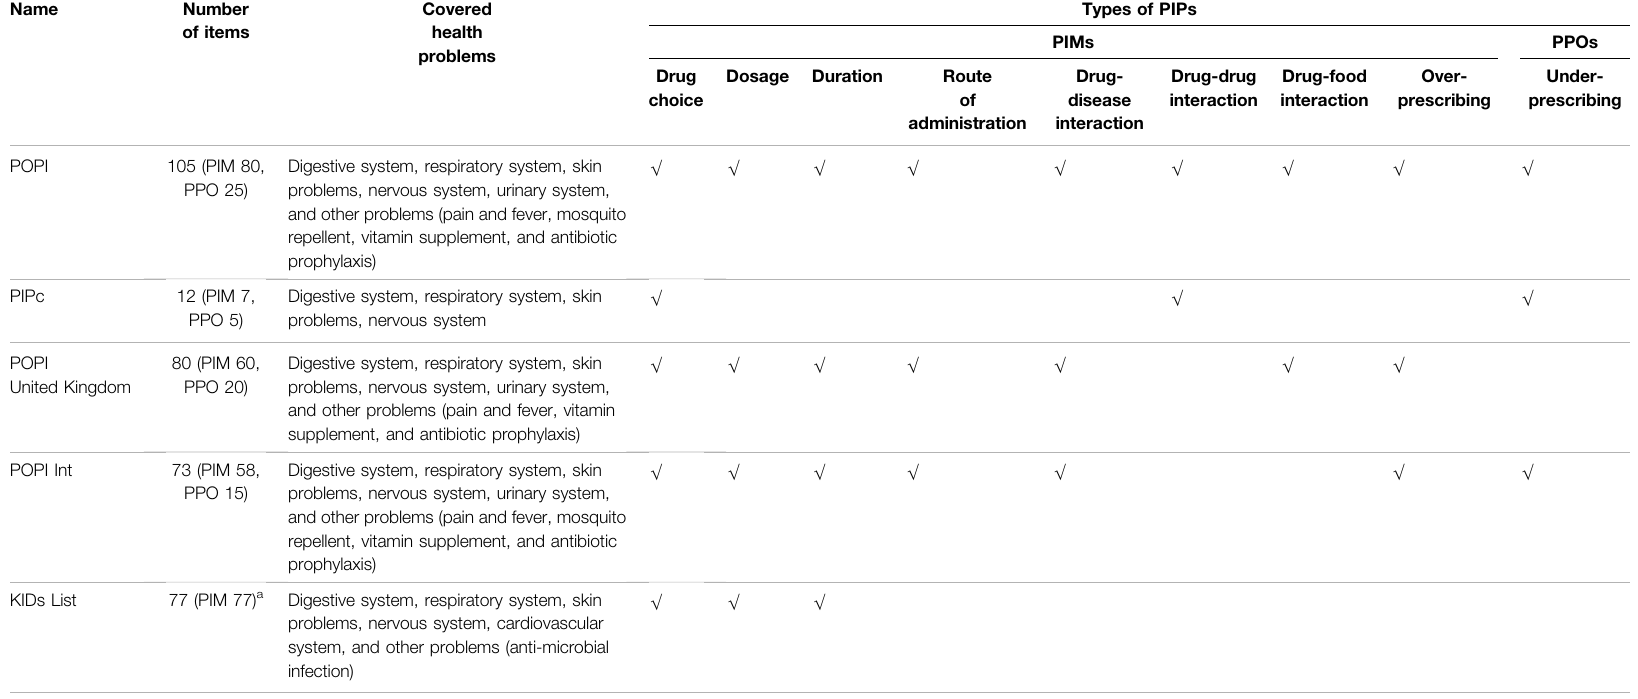
TABLE 2 | Comparison of children ’ s PIP screening tools.